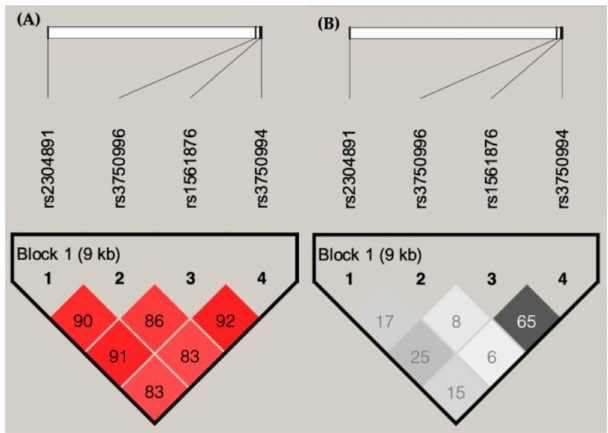
Figure 3. Linkage disequilibrium (LD) plots showing ( A ) D’ and ( B ) r 2 of 4 SNVs of STIM1 in breast cancer patients.